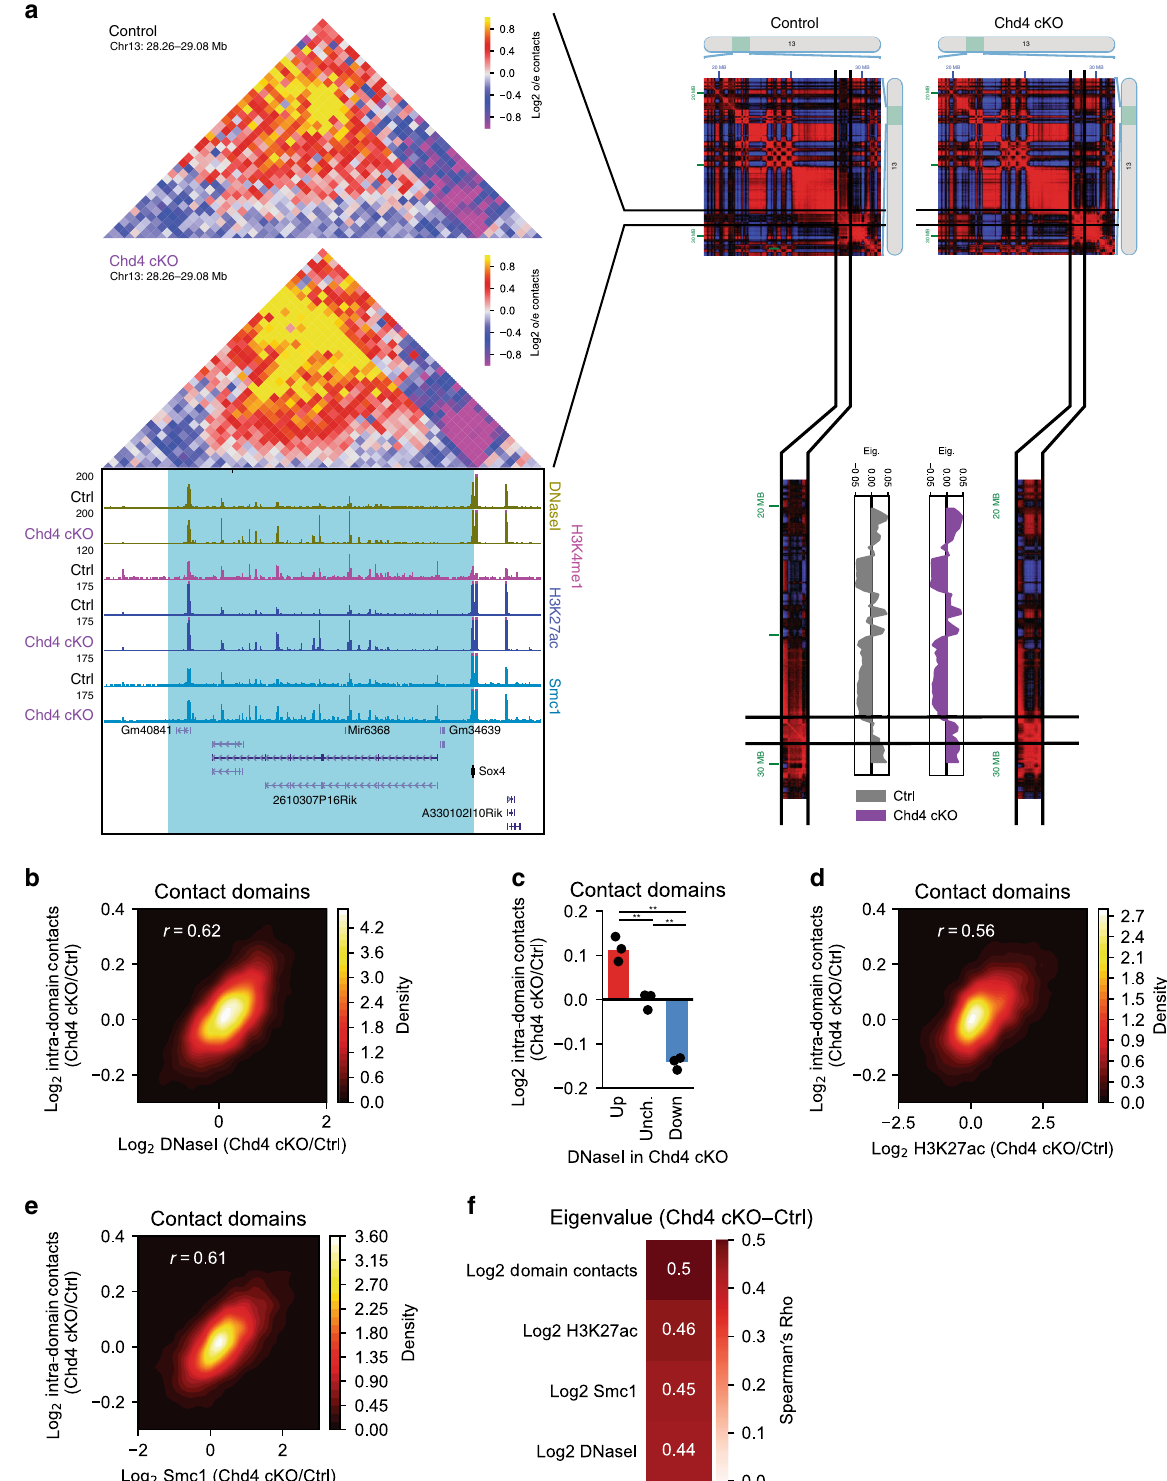
of contact domain interaction frequency upon conditional Chd4 knockout correlated with alterations in H3K27 acetylation and conditional Chd4 knockout on contact domain interaction (Supplementary Fig. 3G – I) and in domains called using the